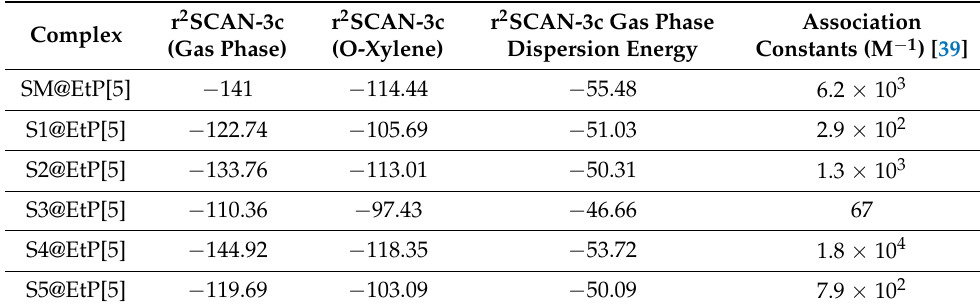
Table 2. Calculated complexation and dispersion-corrected energies (kJ/mol) and experimental values of association constants in M − 1